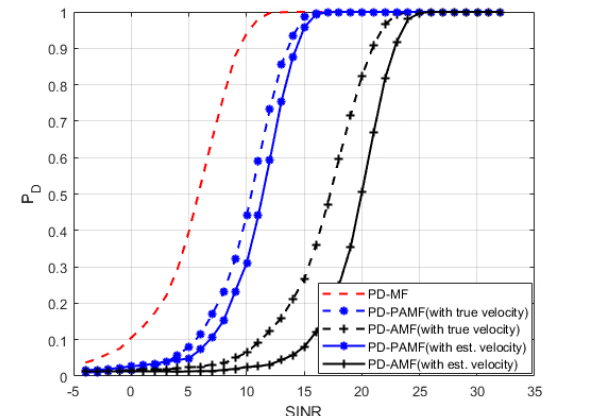
Figure 4. Probability of Detection versus SINR, AR(3), P FA = 10 − 2 , K = 11.